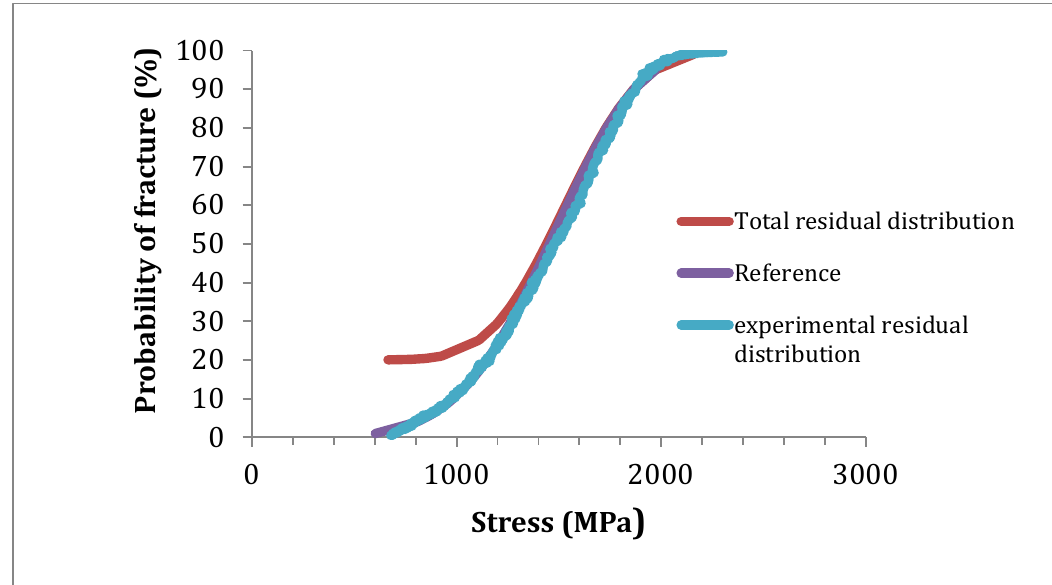
Figure 9. Experimental residual distribution, experimental distribution of reference strengths, total distribution of residual strengths predicted using Equation (4) for filaments.